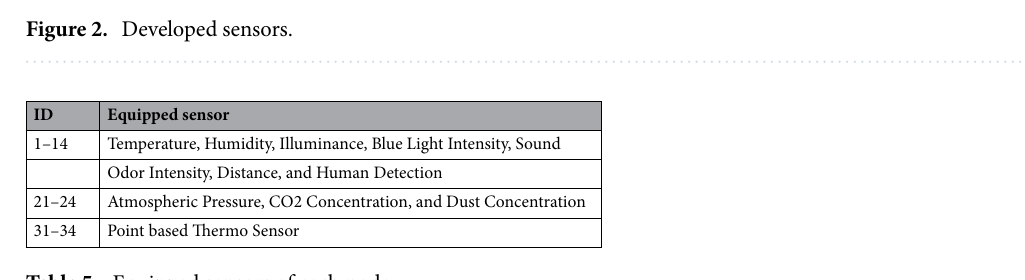
Table 5. Equipped sensors of each